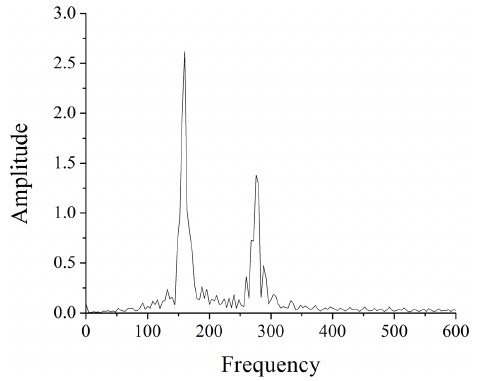
Fig. 10. Fourier power spectrum for the time series in Fig. 9. The continuous broadband noise indicates relatively weak chaotic be- haviour of the system.